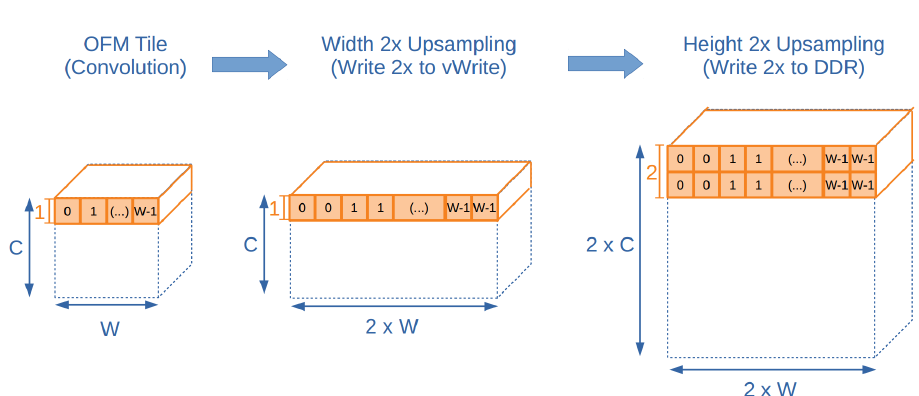
Figure 7. Upsampling after convolution diagram.